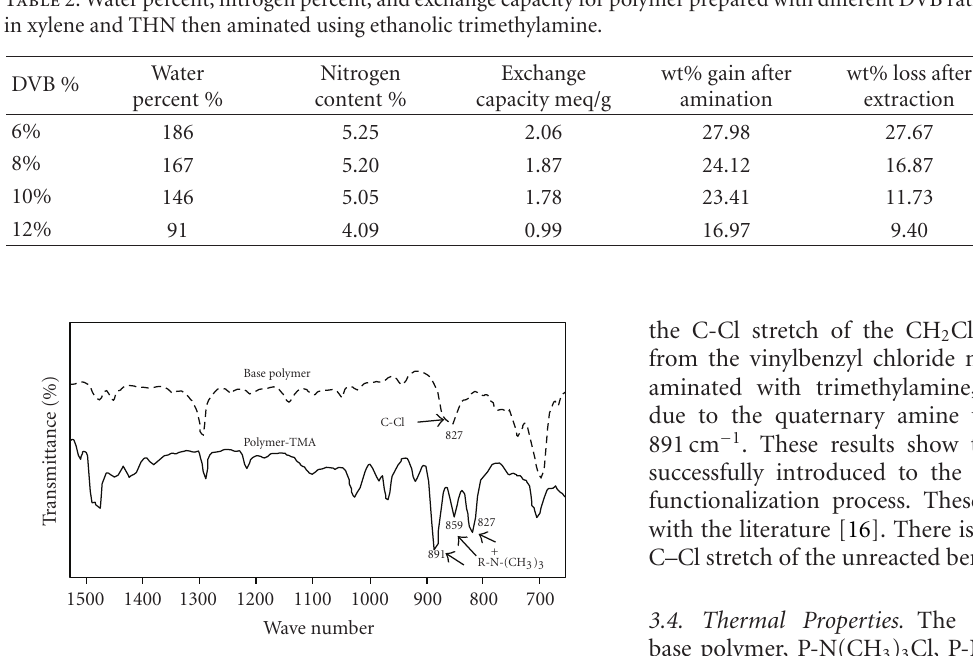
Figure 7: FT-IR spectra of the anion exchange polymer.